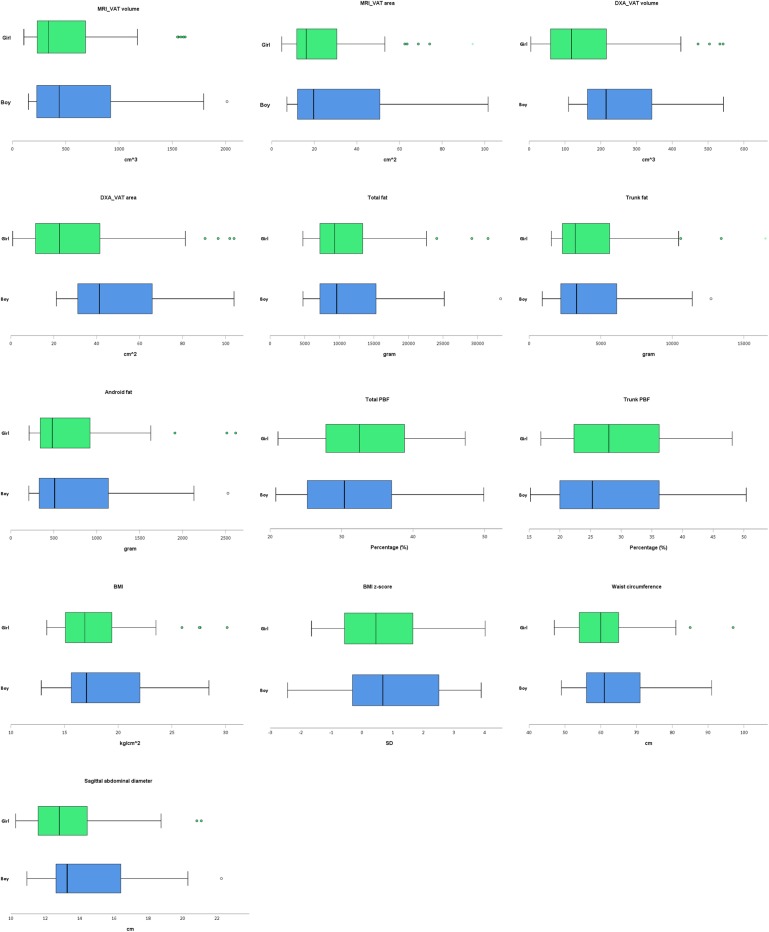
Visceral fat estimates among the study population.In the boxplot, the thick line in the middle of the box is the median. The left and right edges of the box are located at the first and third quartiles. The whiskers show the maximum and minimum values, with the exceptions of outliers (circles) and extremes (asterisks).